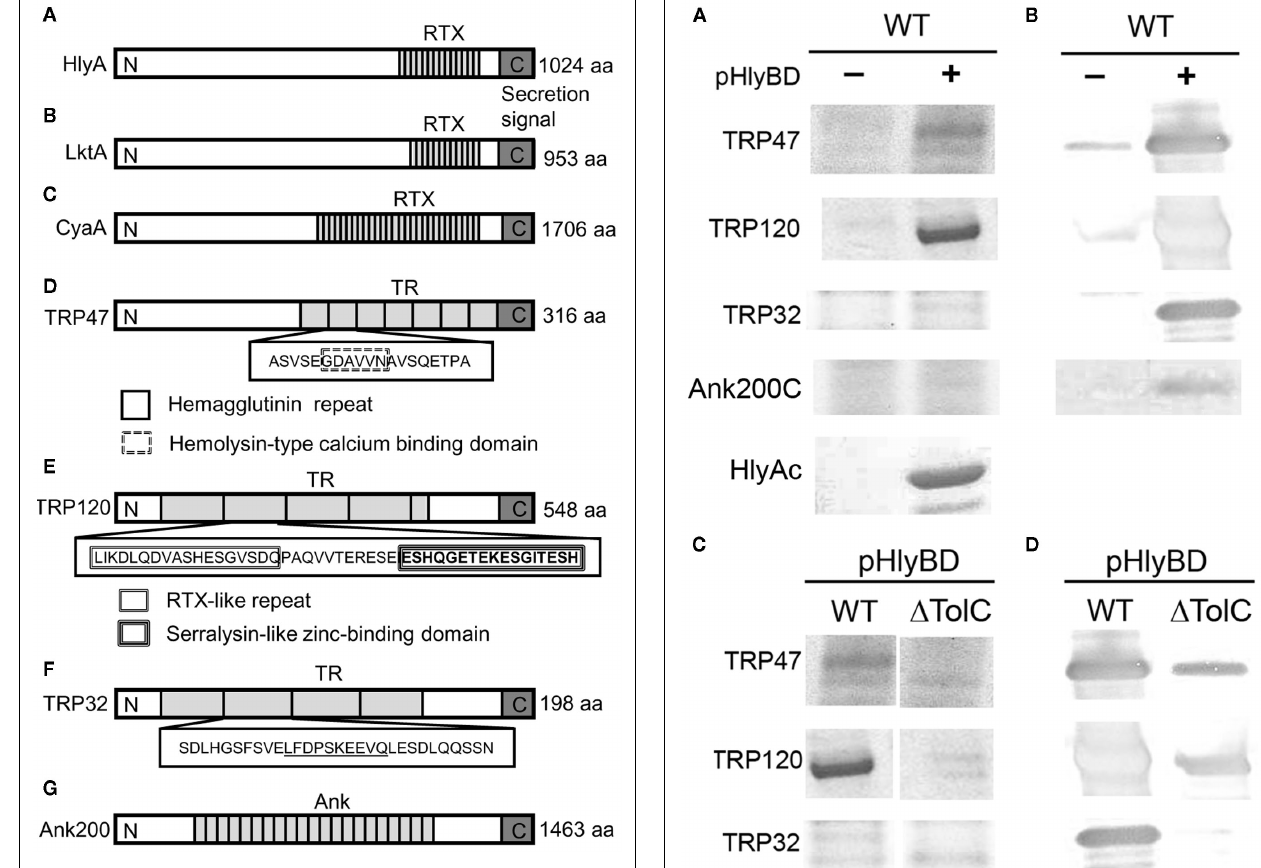
FIGURE 5 | Schematic domain structures of the RTX toxins and E. chaffeensis TRPs andAnk200. RTX, Repeats-in-toxin in (A) E. coli HlyA, (B) P. haemolytica LktA, and (C) B. pertussis CyaA. (D) The putative hemagglutinin repeat and hemolysin-type calcium (Ca 2 + )-binding repeat in TRP47TR are shown as white box with solid boundary and white box with double broken line boundary, respectively. (E) InTRP120, the RTX-like repeat of the aspartic acid and glycine-rich region and serralysin-like zinc-binding domain of histidine and glycine-rich region that are similar but not identical to RTX repeats and serralysin motif are indicated by double lined white box and triple lined white box, respectively. (F) TRP32TR amino acids sequences are shown in white box with solid boundary and the amino acids sequences exhibiting greater than 75% sequence identity to ABC transporter permease and zinc metallopeptidase proteins are underlined. (G) Ank200 with centrally located ankyrin repeats (Ank). Overall, the boxed and underlined amino acid sequences represented in the figure indicated similarity toT1SS secreted proteins.The domain labeling is as follows: RTX, repeats-in-toxin domain;TR, tandem repeats domain; Ank, ankyrin repeats domain (map not to scale).TheT1SS protein secretion signal is shown at the extreme C-terminal end of the proteins (gray colored box marked with C).The tandem repeat regions which vary in number and size of the repeat are shown as gray boxes. N and C represent the N and C-terminus of the protein, respectively.